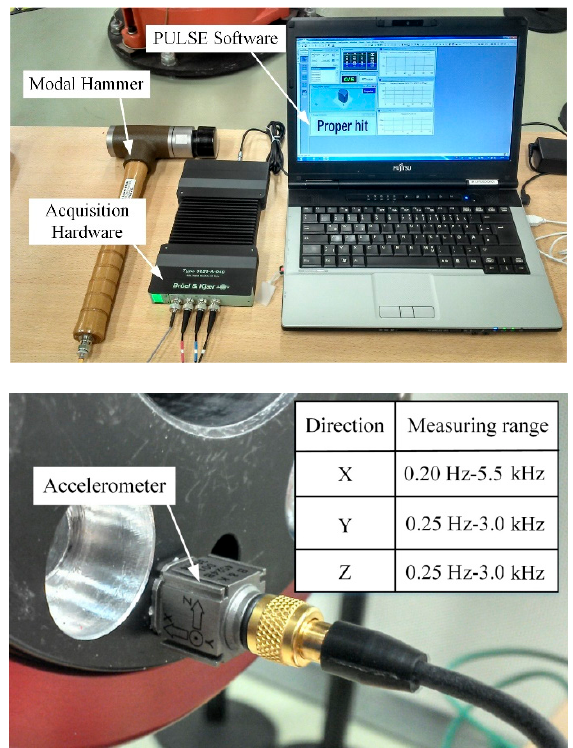
Figure 1. Modal analysis system configuration.